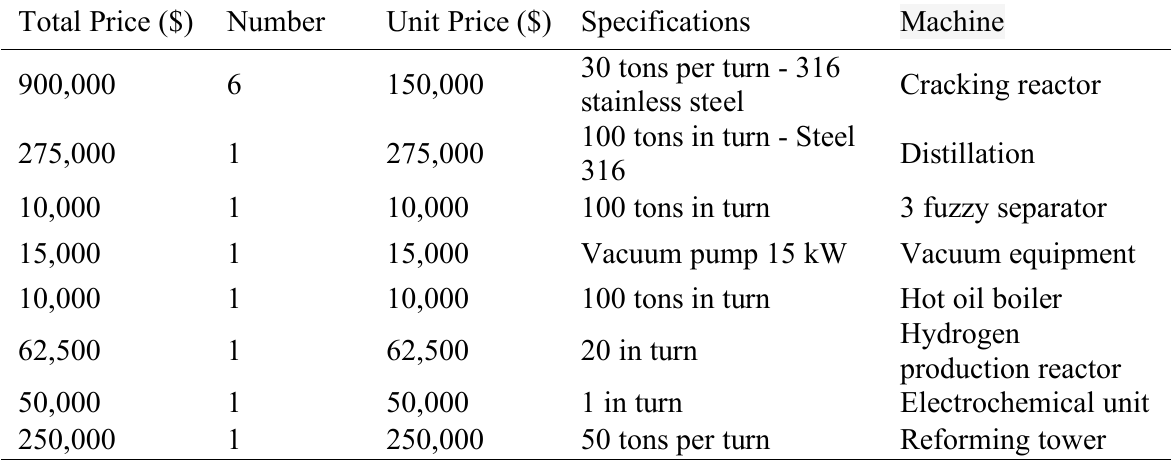
Table 2. List of main equipment